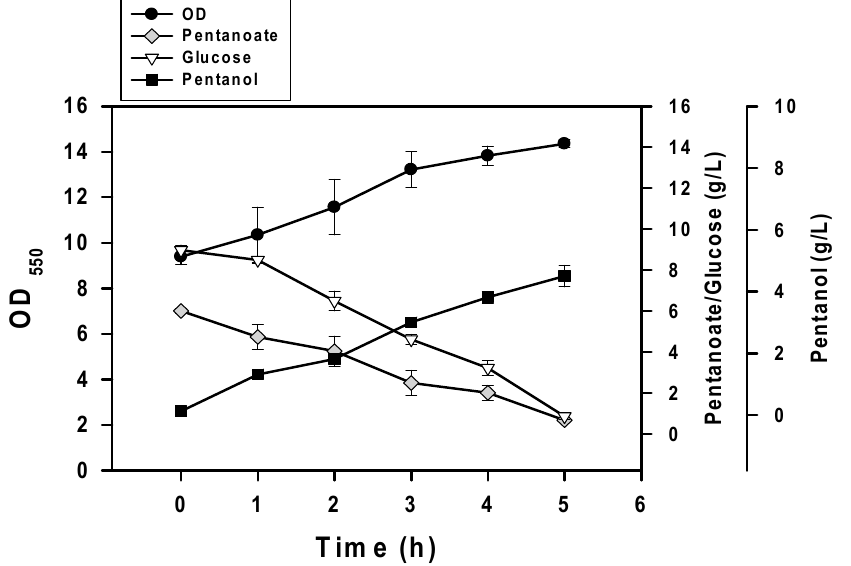
Figure 5. Improved production of n-pentanol. The fermentation of BuT-3EP strain was carried out with glucose (10 g/L) and n-pentanote (6 g/L). The fermentation was then followed along the time course. The experiment was conducted in triplicate.